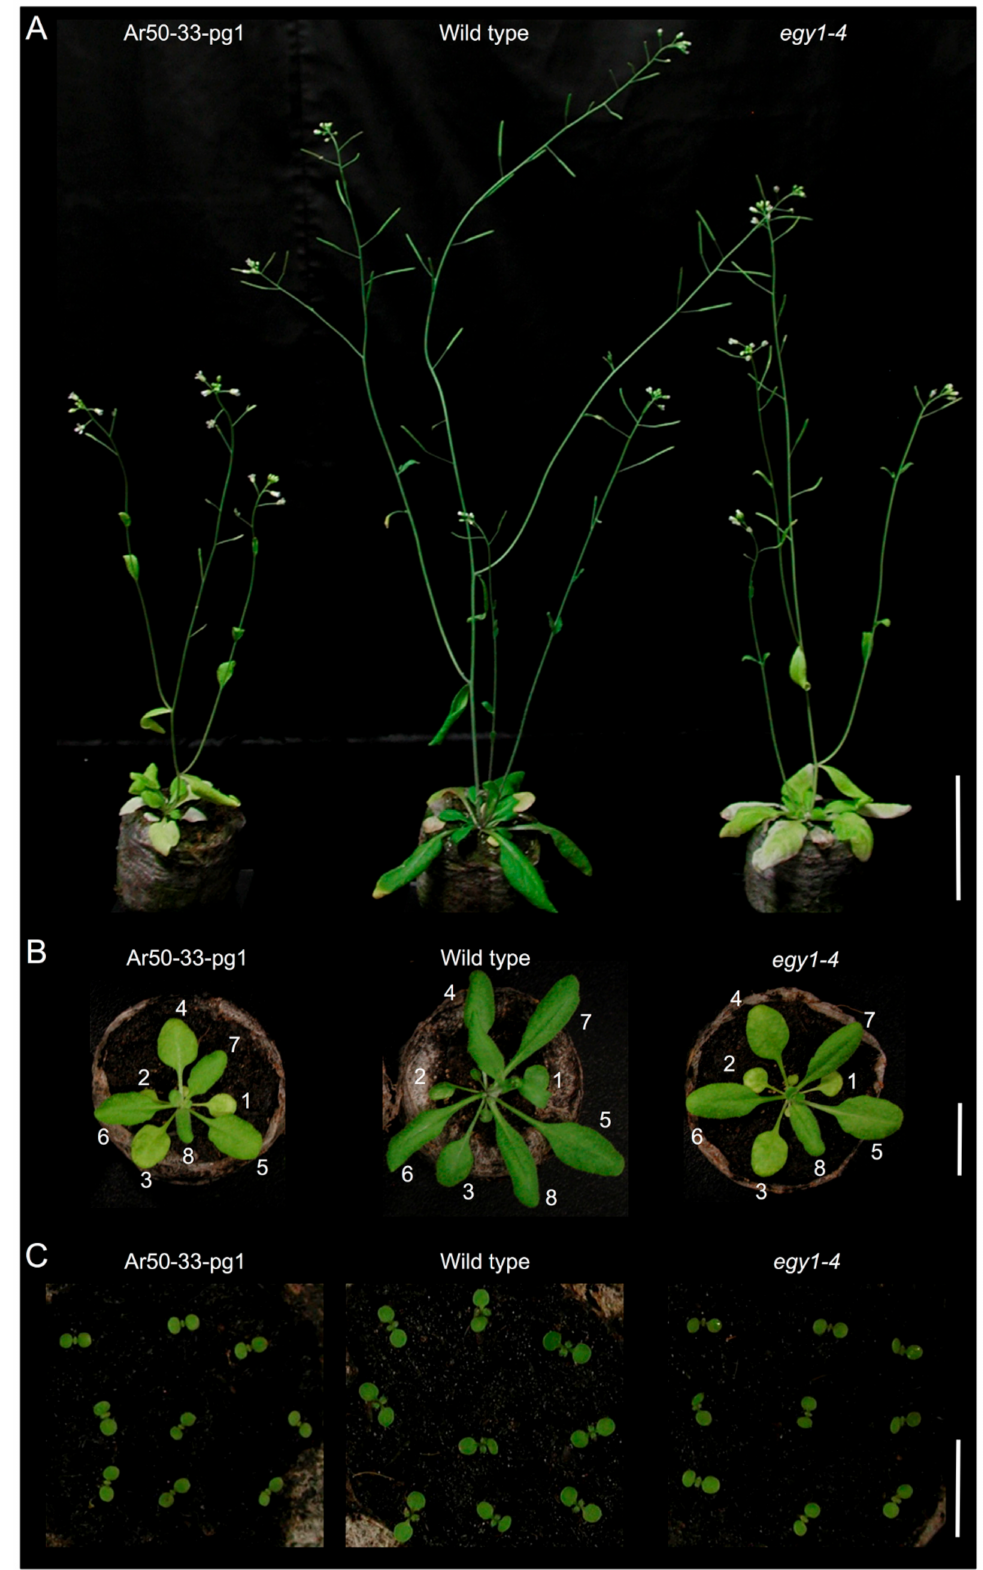
Figure 1. Growth and shoot morphology of wild type and mutant plants. ( A ) Five-week-old Ar50- 33-pg1, wild type, and egy1-4 plants. ( B ) Three-week-old plants. ( C ) One-week-old plants. Numbers in ( B ) indicate the order of leaf emergence. Bar = 5 cm ( A ), 2 cm ( B ), and 1 cm ( C